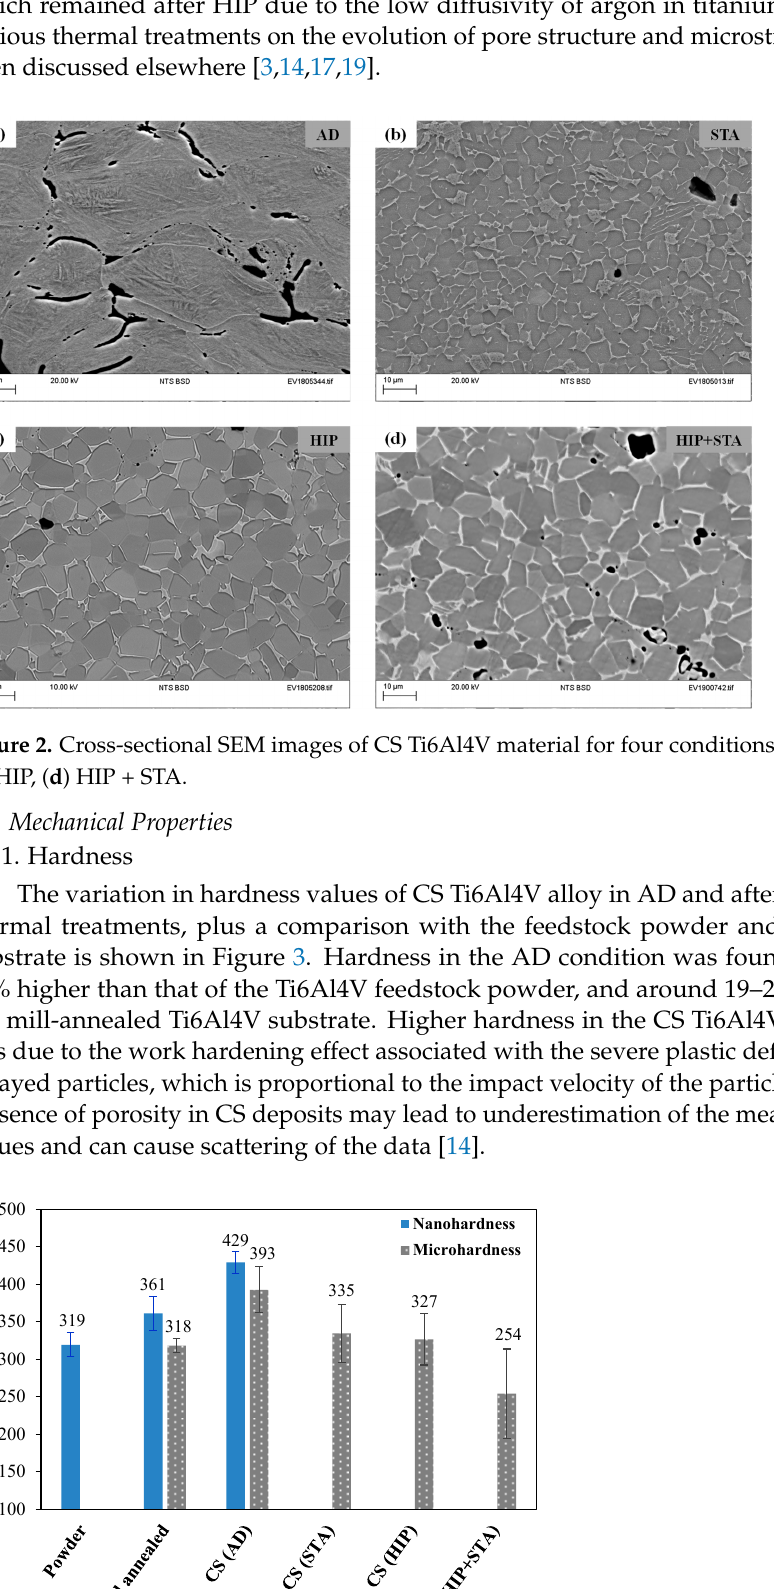
static recovery mechanisms during high-temperature annealing processes, transforming work hardened microstructure to equiaxed microstructure through recovery, recrystalli- zation, and phase transformation [3,14]. High-temperature thermal treatments promoted the growth of β phase vanishing the ‘smooth’ and ‘textured’ regions of CS Ti6Al4V de- posits possessed in the AD condition [14]. For HIP + STA treated specimens, a significant decrease in hardness (35% reduction from that of the AD condition) was observed, which was attributed to the observed increase in porosity. 3.2.2. Tensile Properties Tensile properties for fully CS and CS repair specimens are presented in Figure 4 for four different conditions, i.e., AD, STA, HIP, and HIP + STA. Figure 4a,b show the stress– strain relationship for fully CS and CS repair specimens, respectively. Figure 4c–e show- ing values of E , UTS, and elongation. In the AD condition, fully CS specimens failed in a brittle manner at 287 ± 7 MPa UTS and 0.44% elongation with no yield point. The E value calculated from the stress–strain curve for the fully CS Ti-64 (AD) was found to be 76 GPa, which was about 32% lower than the mill annealed Ti6Al4V (112 GPa). However, from the IET measurements, E obtained for CS Ti6Al4V AD material (88 GPa) was around 16% higher than the values obtained from the stress–strain curve (76 GPa).